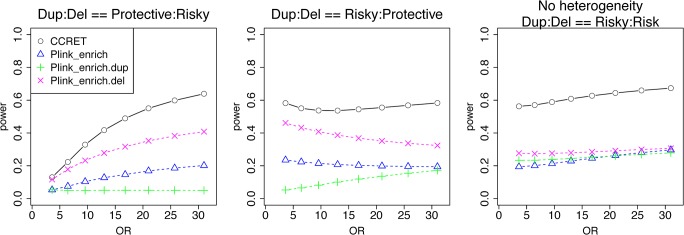
Power comparison between CCRET and PLINK 2-sided tests for simulation II-B: within-locus heterogeneity of the GI simulation, under 3 heterogeneity models as detailed in section “Simulation Design”.Black O line: CCRET; Blue Δ: PLINK 2-sided test analyzing deletions and duplications combined; Green +: PLINK 2-sided test analyzing only duplications; Magenta x: PLINK 2-sided test analyzing only deletions.